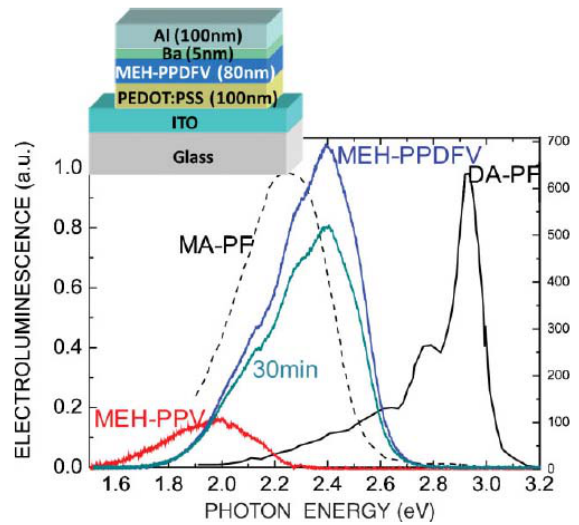
Figure 6. EL spectra in thin films of MEH-PPV (red curve) and its fluorinated analog MEH-PPDFV at starting time (blue curve) and after 30 min (dark green curve) of continuous operation. For comparison, the normalized EL spectra of an ITO/ MA-PF /Al and of an ITO/ DA-PF /Al [37] (left vertical axis) are also shown, where MA-PF indicates a 9-monoalkylated polyfluorene and DA-PF indicates a 9,9-dialkyl polyfluorene. Reproduced with permission from ref. 33. Copyright Wiley-VCH Verlag GmbH & Co.